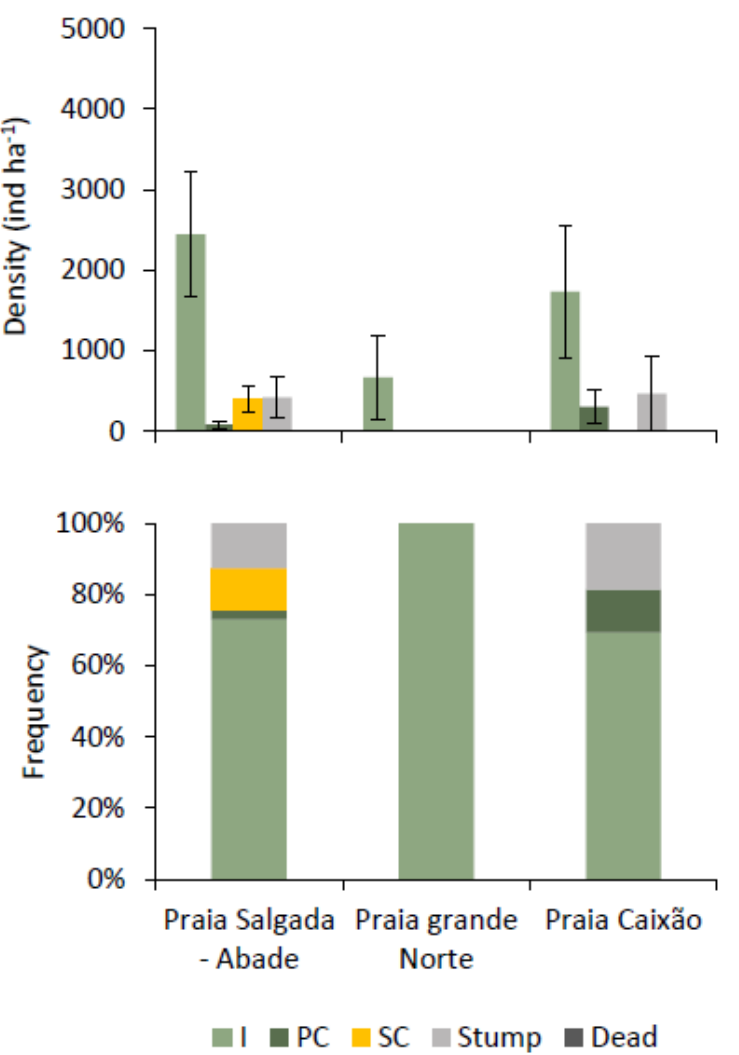
Figure 5. Density (± SE) and frequency of intact (I), partially cut (PC), severely cut (SC), stumps and dead trees, on Príncipe